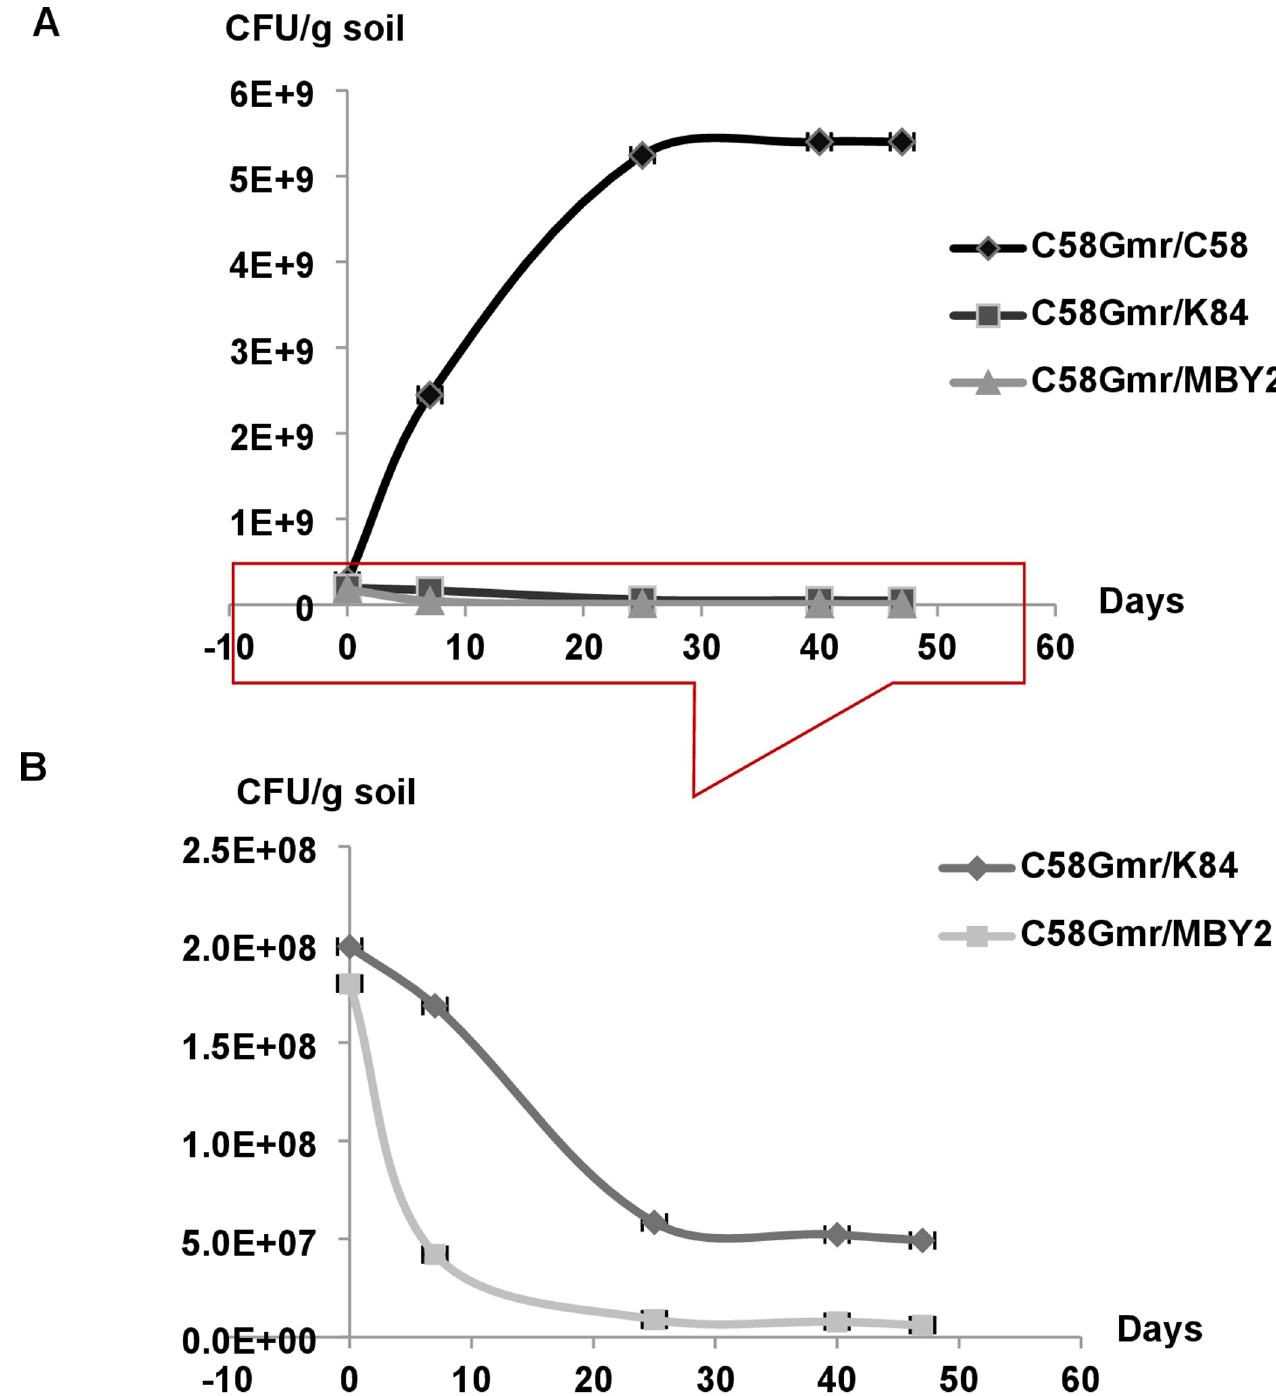
Fig 3. Inhibition of growth of A . fabrum C58Gm r by B . velezensis MBY2 in sterile bulk soil. A . fabrum C58Gm r was co-inoculated (1:1 ratio) with B . velezensis isolate MBY2, A . radiobacter K84 as positive and A . fabrum C58 as negative control at a rate of 10 8 CFU/g in sterile bulk soil. Numbers of the C58Gm r bacteria were determined by plating onto YPG medium and YPG + 30 μ g/ml gentamycin. Data are presented as the average of three biological replicates of one representative experiment. The lower section of part A has been enlarged for better resolution in part B of the figure.